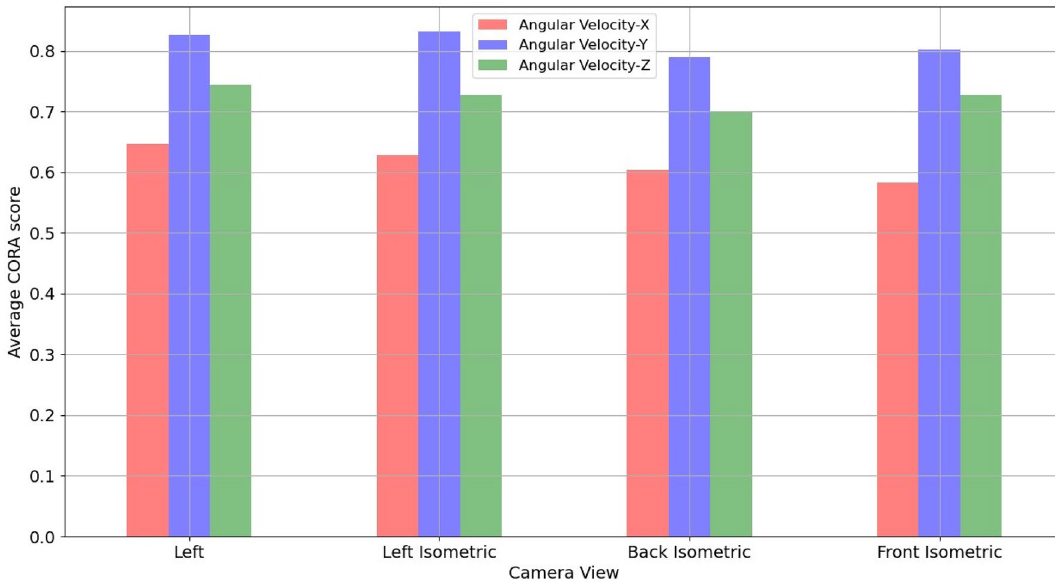
Figure 14. Average CORA scores for each camera view.